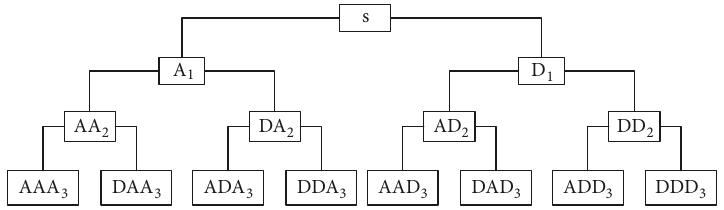
Figure 11: Wavelet packet decomposition